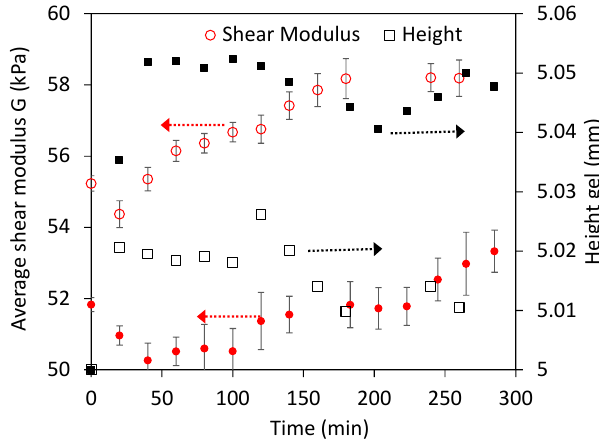
Figure 7. Shear modulus and height of particulate gels swollen in water (filled points) and in 0.1 M NaCl (empty points). Particulate gels were made with 0.1 M NaCl, heated at 80 °C for 1 h. Note that both the modulus and the height change little with time. Error bars are as in Figure 5.